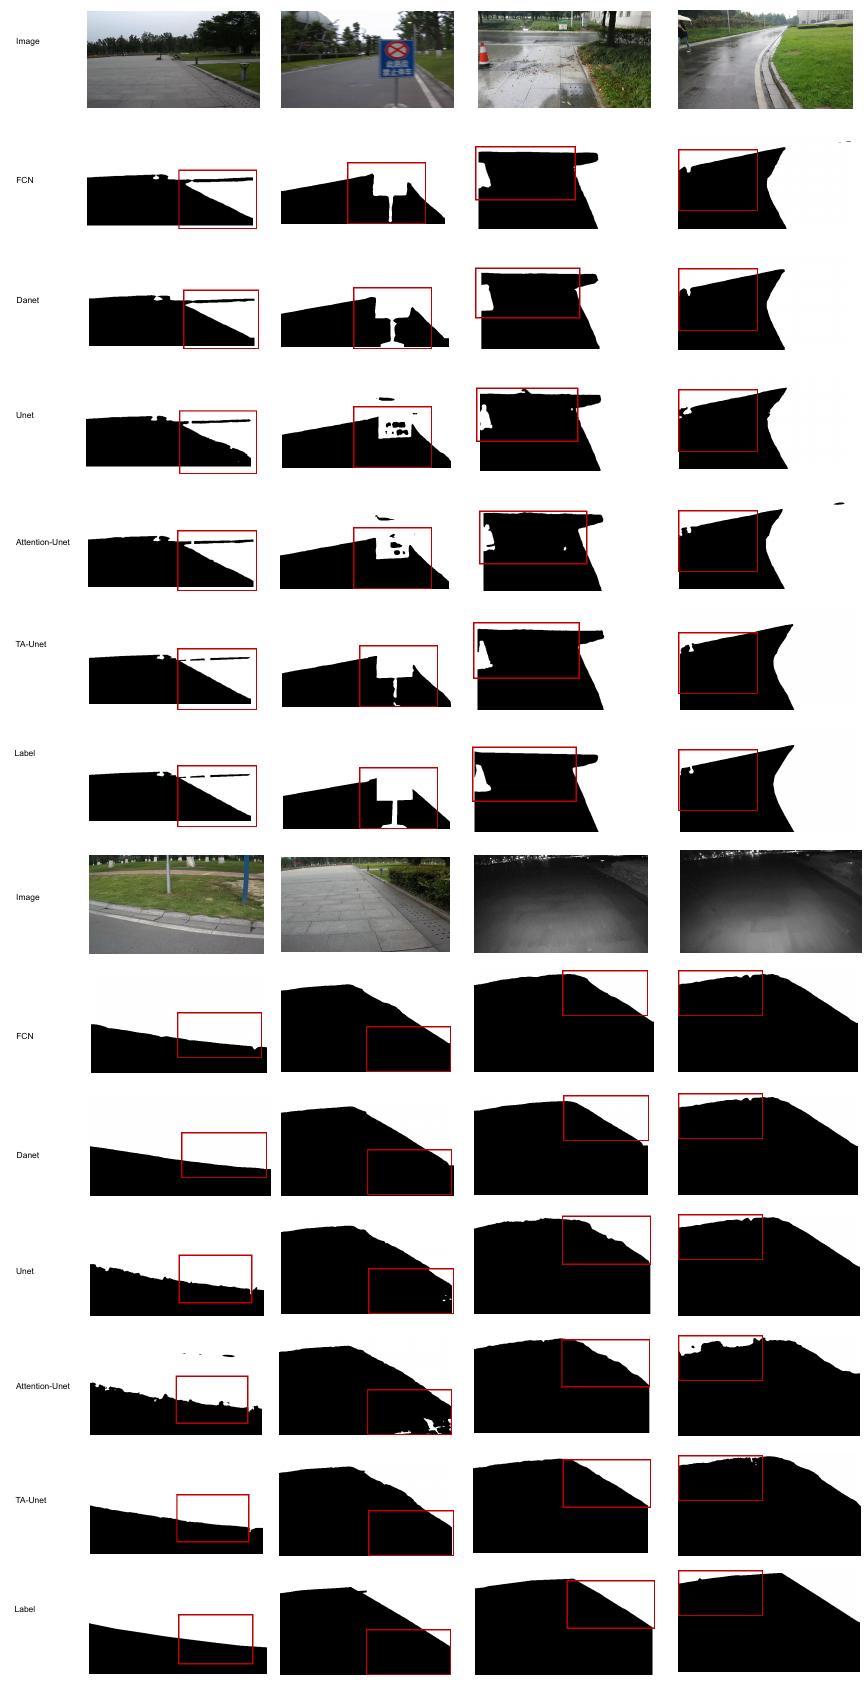
Figure 4. Road segmentation results of different methods in different